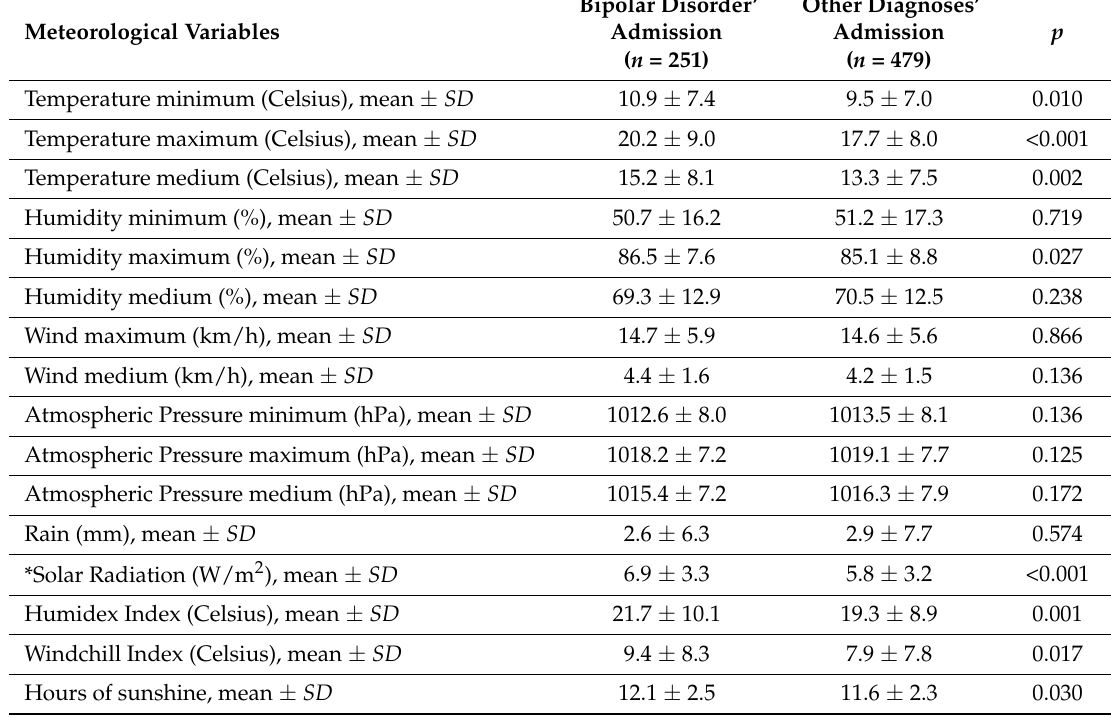
Table 2. Difference on meteorological variables in terms of admission in an emergency psychiatric ward between bipolar disorder (BD) and other diagnosis.